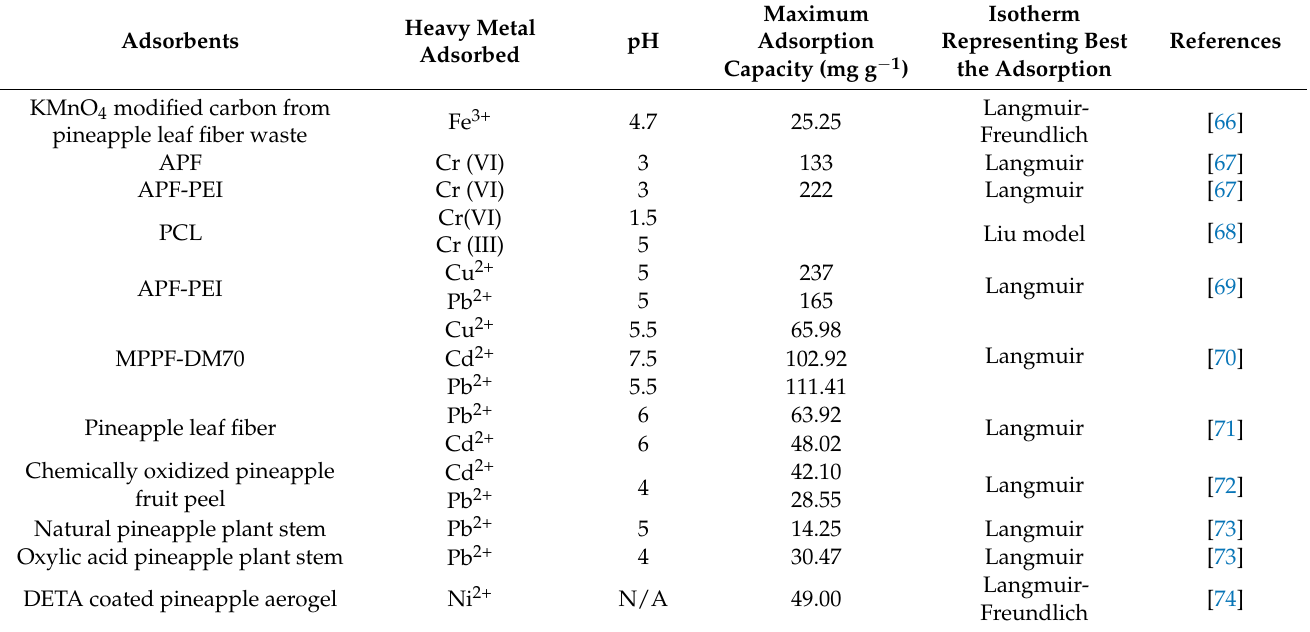
Table 2. Summary of some reported studies in which pineapple and components were used as adsorbents for the removal of heavy